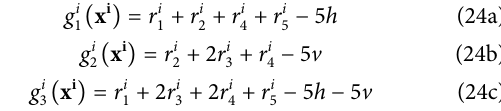
Frontiers in Built Environment |